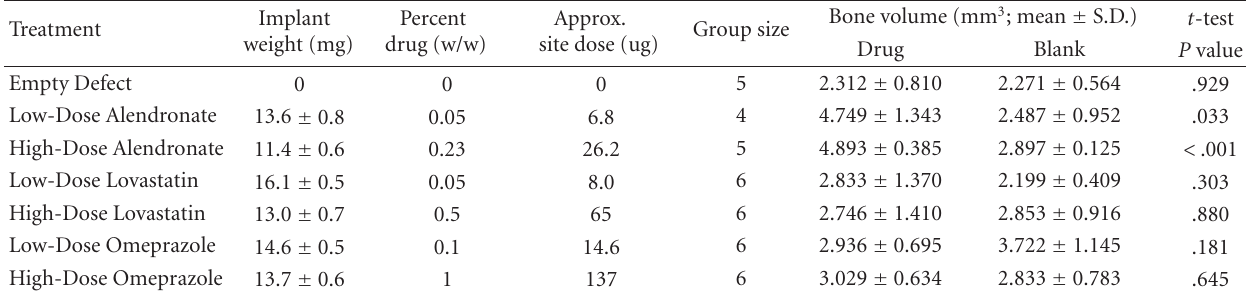
Table 2: E ff ects of Drug Therapy on New Bone Volume.